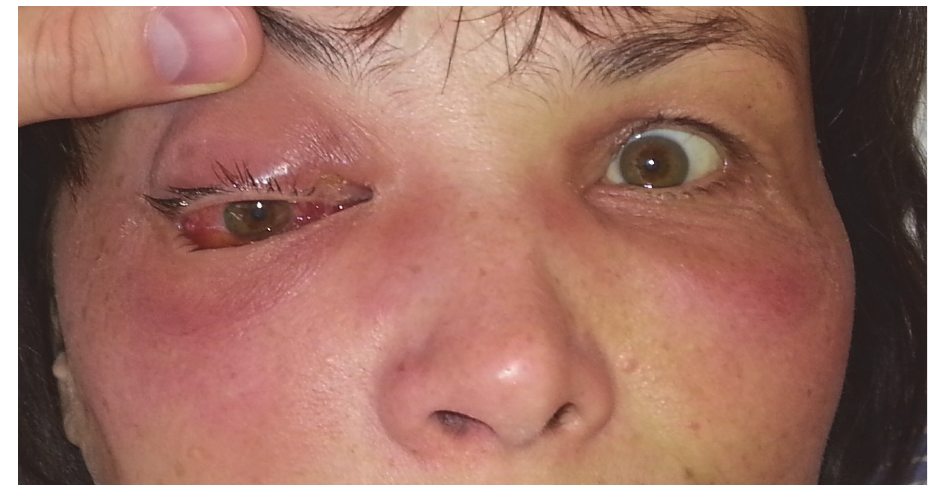
Fig. 2. Orbital cellulitis as the complication of MRONJ-induced maxillary rhinosinusitis and ethmoiditis in the patient from Fig.